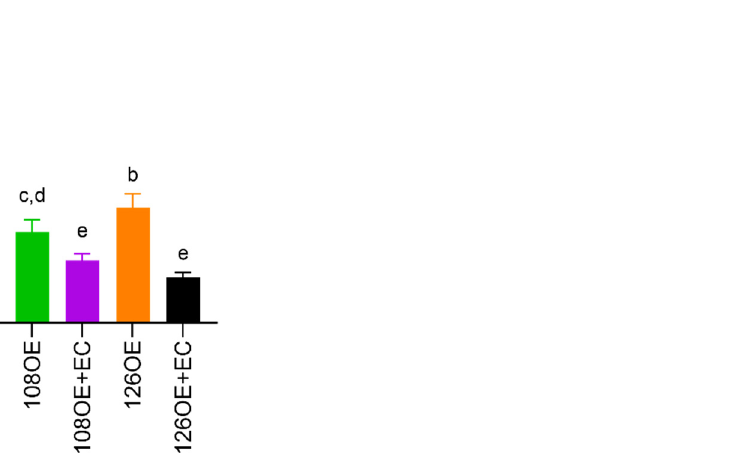
Figure 7. Accumulation of lipids after differentiation of Tas2r108 - or Tas2r126 -overexpressing 3T3- L1 preadipocytes. Differentiation of 3T3-L1 preadipocytes overexpressing Tas2r108 (108OE) or Tas2r126 (126OE) was induced with or without epicatechin (EC, 1.0 mM). The cells were stained using AdipoRed™ assay reagent. Con: control, N = 6, different letters (a,b,c,d,e) indicate significant differences compared with the other bars ( p < 0.05, Tukey test).